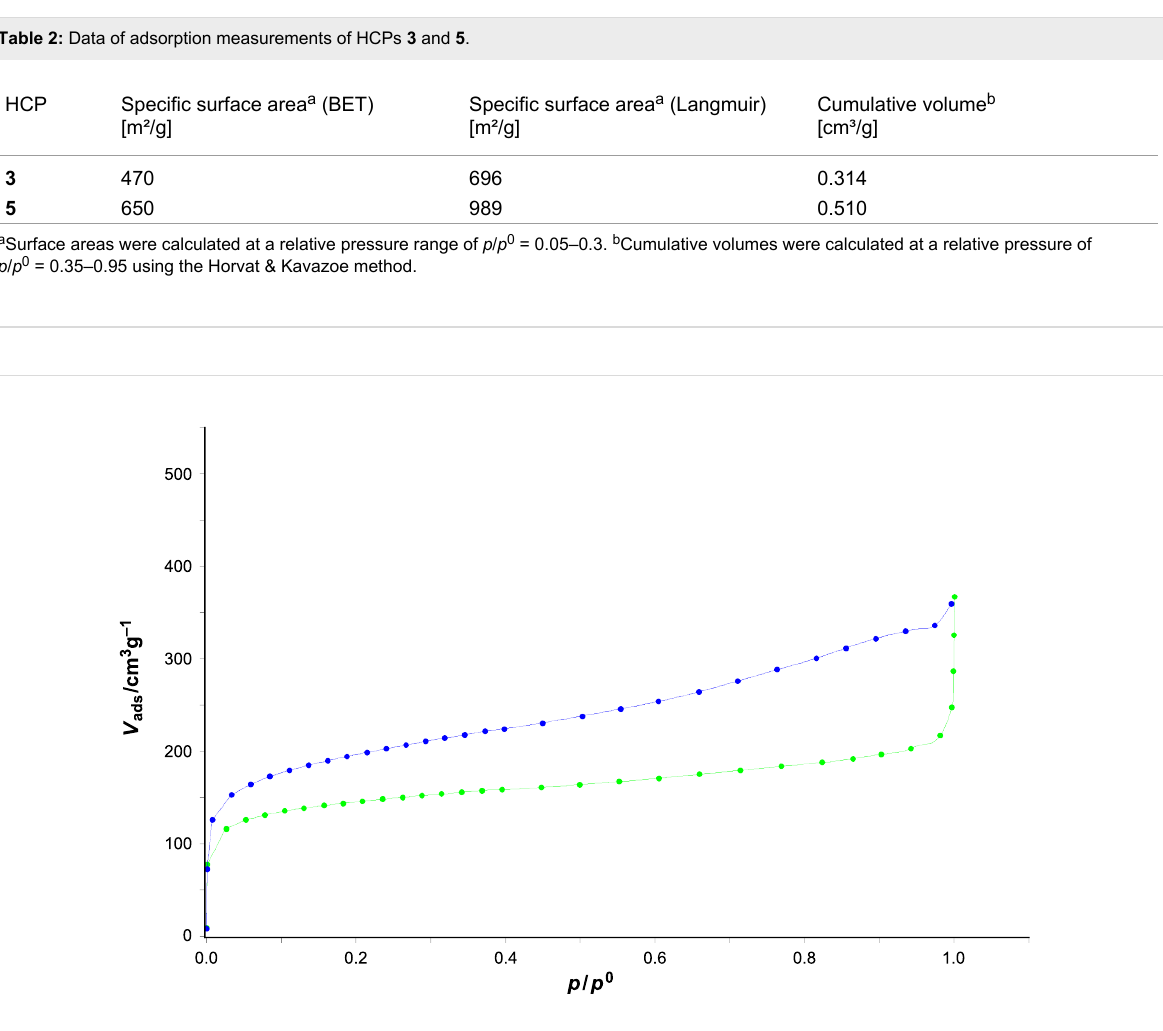
Figure 3: SEM images of HCP 3 (left) and HCP 5 (right).